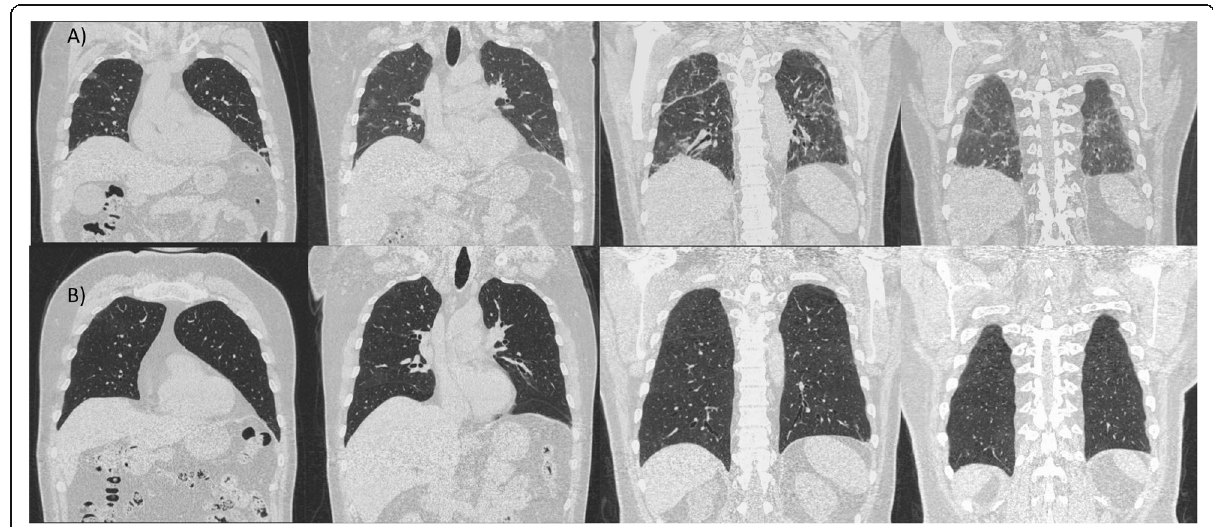
Fig. 4 Case 36: 58-year-old male with a history of hypertension, score 3 at the moment of inclusion. CT chest: a day of inclusion (April 11th). Bilateral multi-lobar multi-focal, peripheral and subpleural mixed attenuation groundglass, nodular, and linear opacities without crazy-paving pattern noted in bilateral lung parenchyma predominantly involving the bilateral lower lobes. b Day 8 after treatment on (April 21st, nebulization did on April 13th). A few scattered areas of ground-glass shadowing in the bilateral lungs. Significant resolution compared to the previous